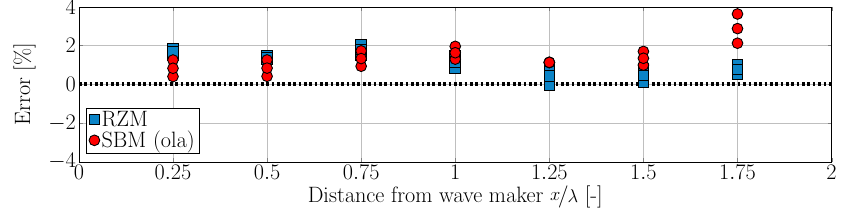
standard deviation σ ¯ (cid:101) along the ¯ H ±